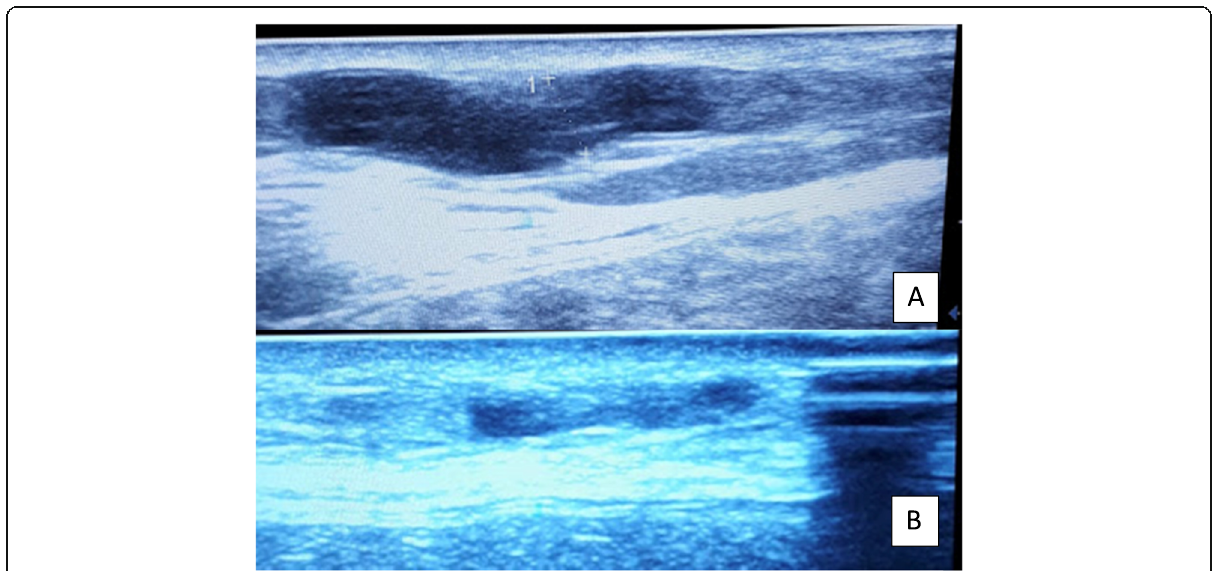
Fig. 4 a First visit ultrasound showing refluxing superficial vein. b Follow-up at the 3rd visit showing diameter changes and echogenic